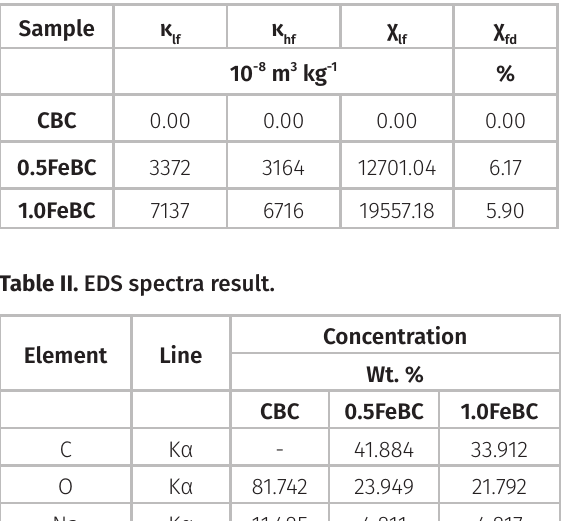
O composite. 2 3